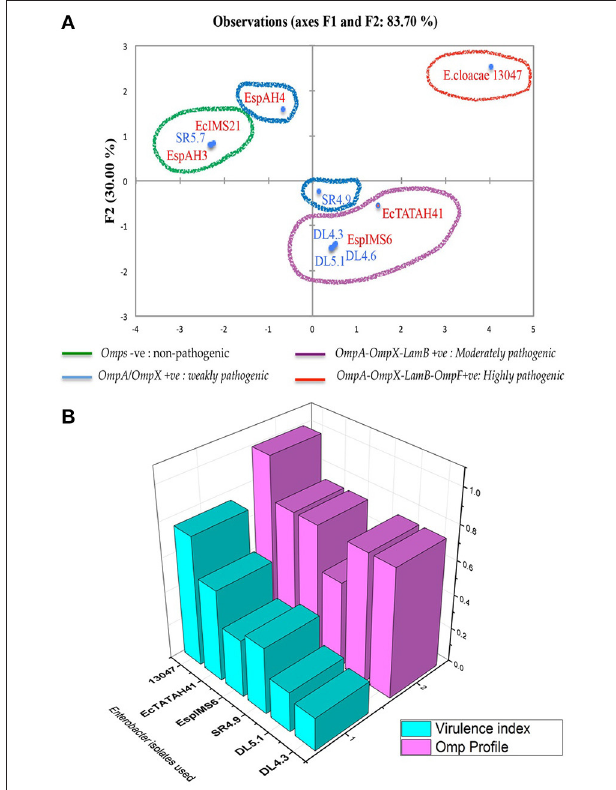
FIGURE 5 | Association of OMPs with pathogenic potential in clinical and environmental Enterobacter isolates. Principal component analysis represented as biplot (A) associating pathogenic potential and expression of OMPs has categorized into four groups, where organisms in red indicated clinical Enterobacter isolates and in blue indicated environmental Enterobacter isolates. (B) is a 3D plot showing the association between of OMP profile with virulence index of individual Enterobacter